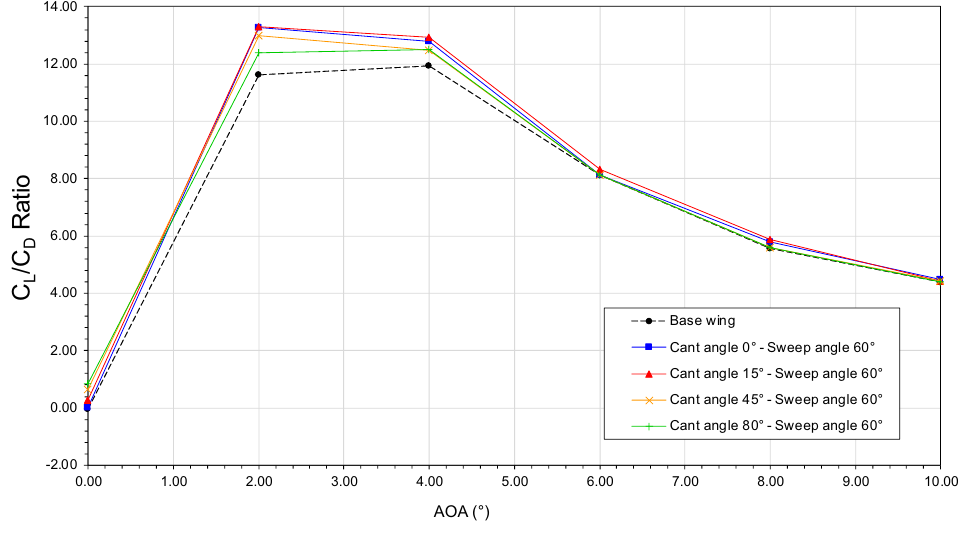
Figure 19. Lift-to-drag ratio versus angle-of-attack at Mach number 0.8395, winglet sweep angle 60 ◦ and different values of cant